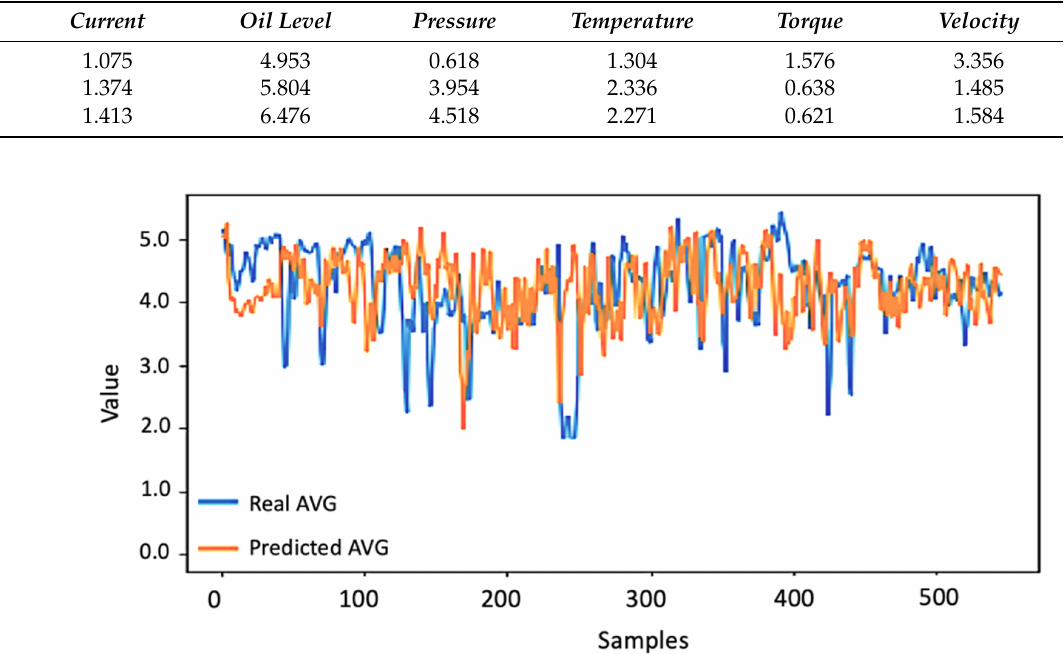
Table 6. Comparison between XGBoost and feed-forward network using MSE.